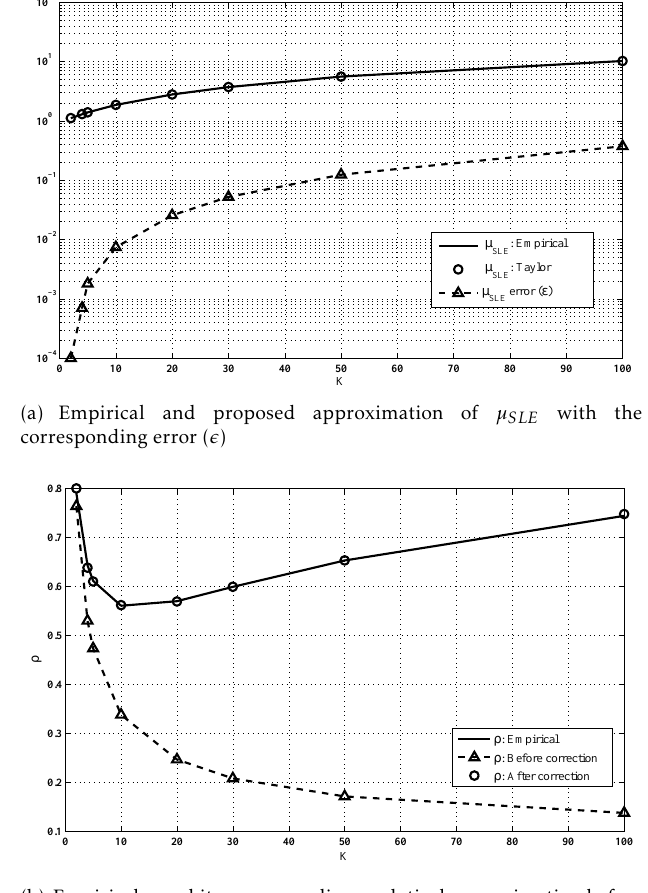
Figure 2. Empirical CDF of the SLE under H its corresponding Gaussian approximation for different values of K with N = 1000 .